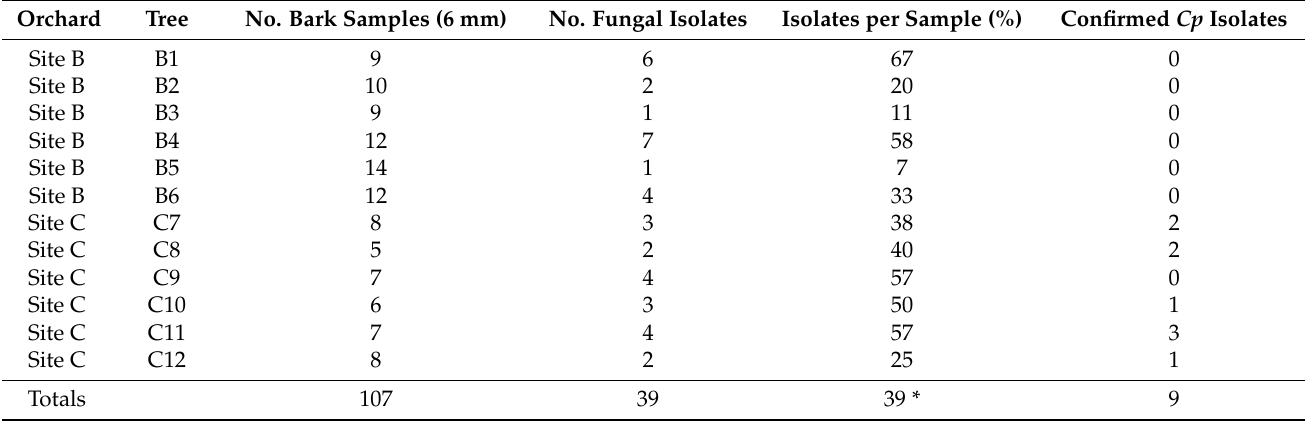
Table 2. Initial samples and isolates from 2017 after 2 d incubation on PDA media.